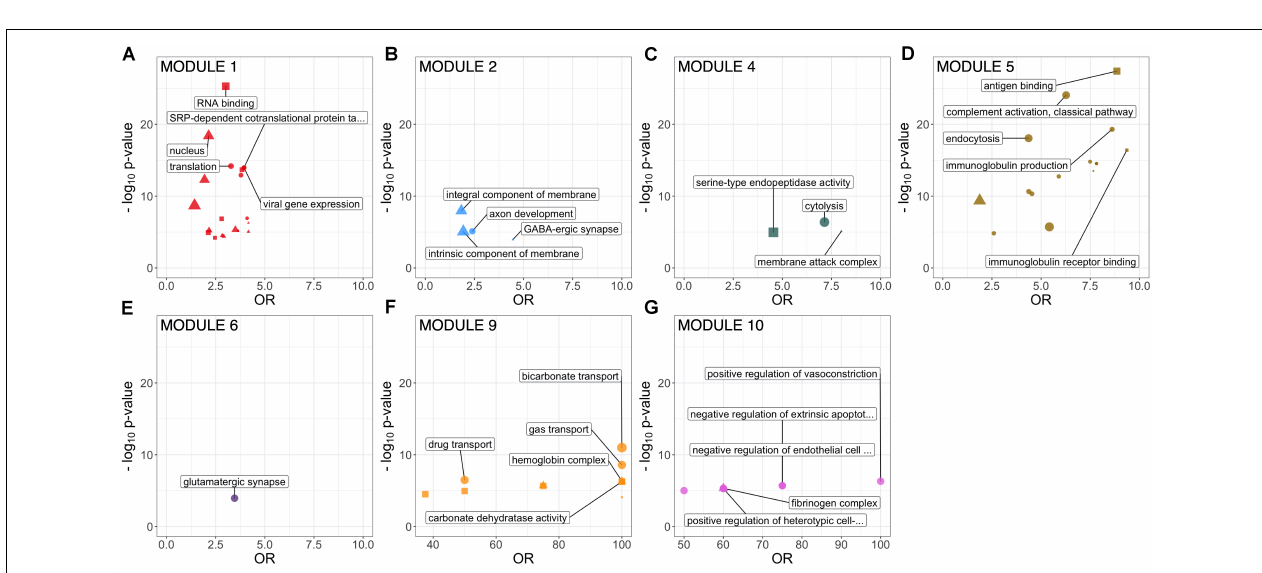
FIGURE 1 | WGCNA of the healthy control CSF proteome. (A) Cluster dendrogram indicating module allocation. (B) Network graph indicating modules. For ease of visualization, pairwise correlations with FDR-adjusted p > 0.01 have been excluded from this graph. CSF, cerebrospinal fluid; WGCNA, weighted gene correlation network analysis.